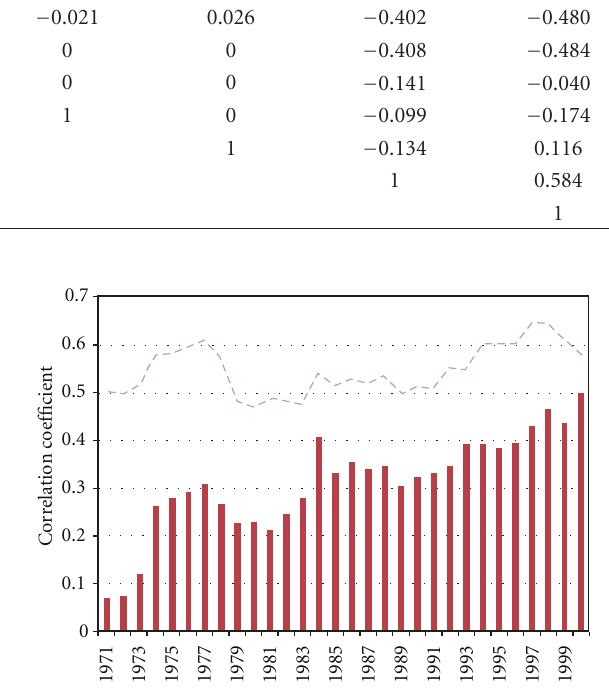
Figure 7: Temporal manifestations of 31-year overlapping seg- ments of correlation coe ffi cients between PC1 and ENSO (solid bars); PC1 and IODZM (broken